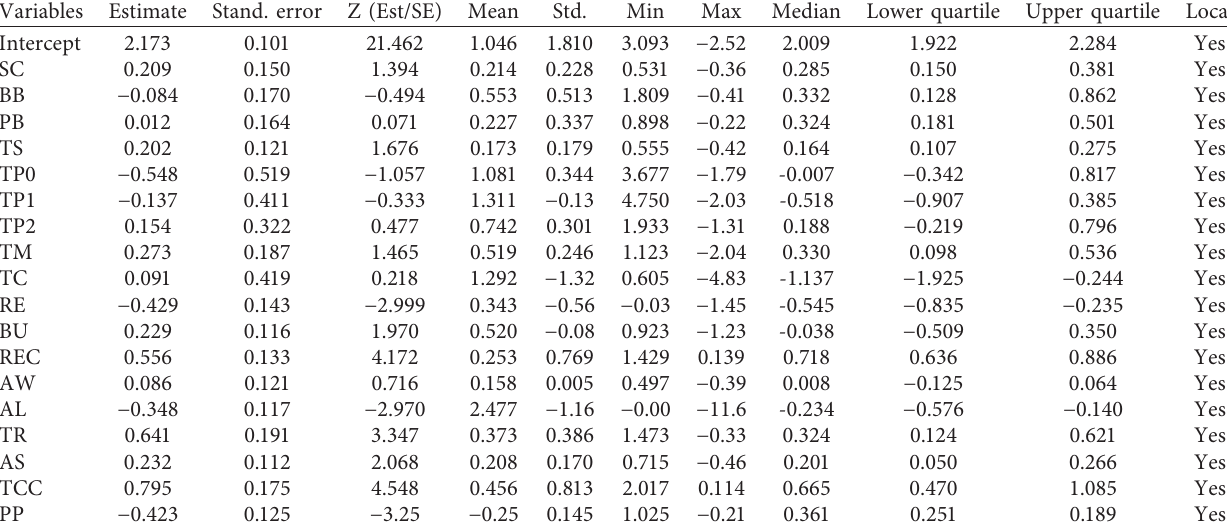
Table 6: Summary results of the GWGR model for predicting